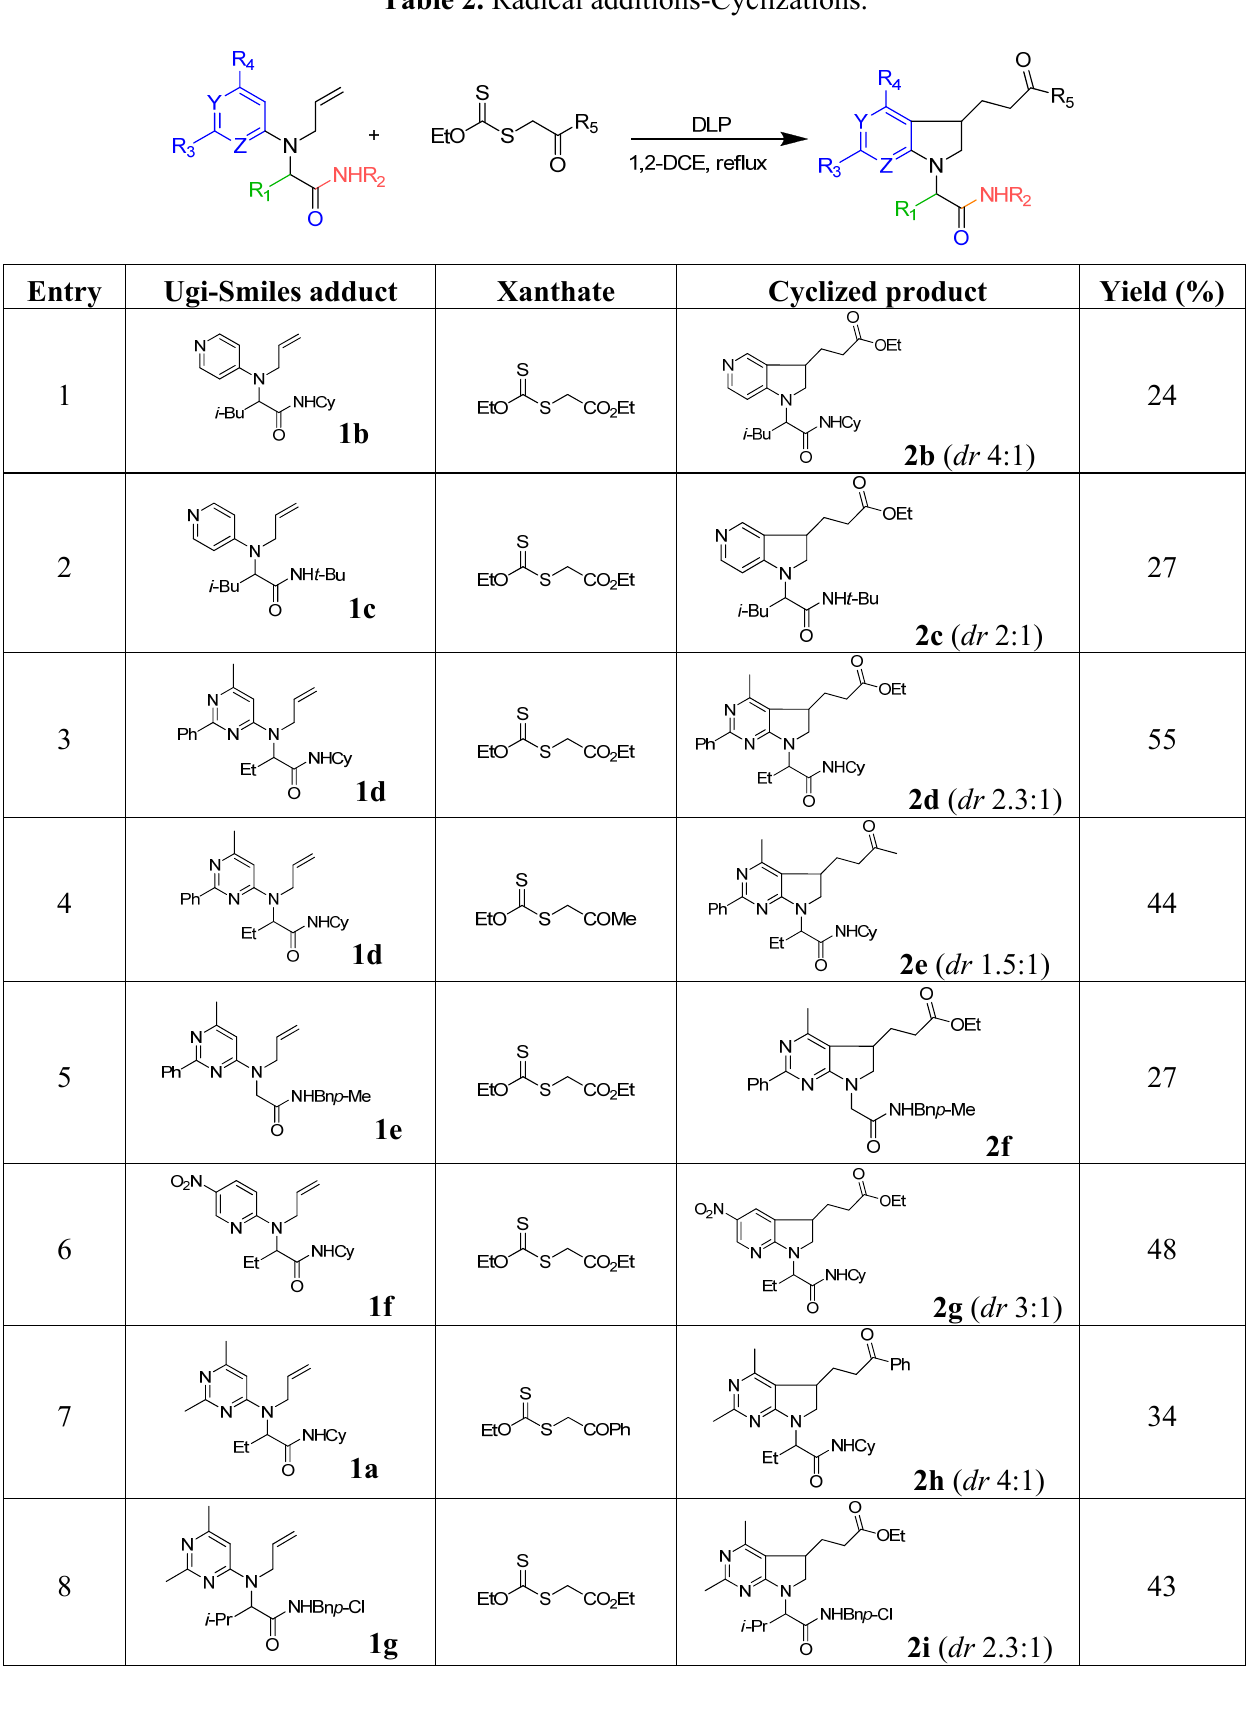
Table 2. Radical